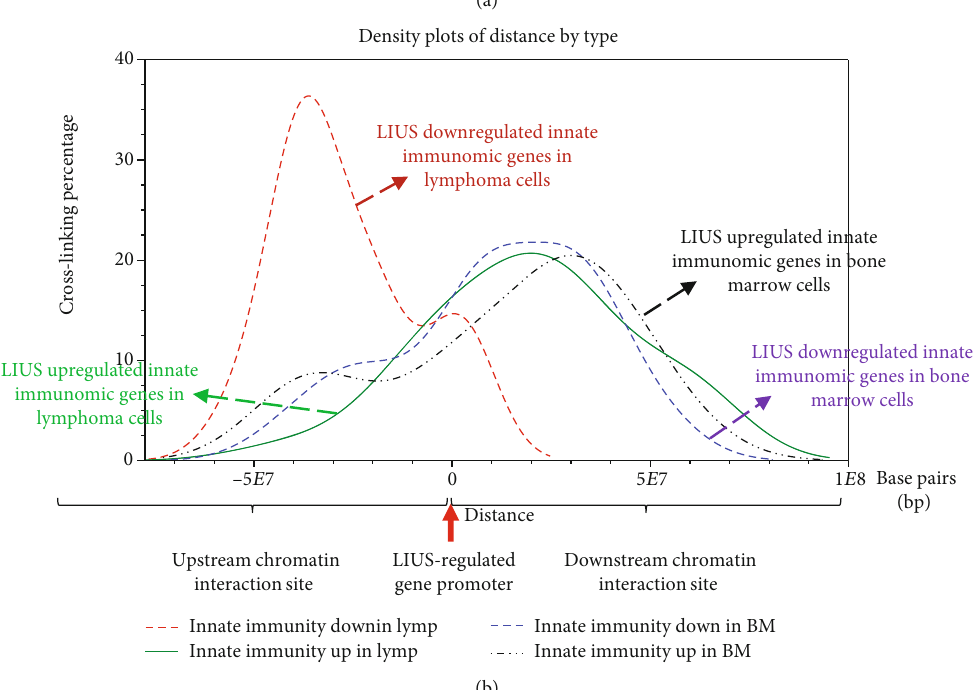
Figure 10: (a) Innate immunome chromatin looping makes long-range interactions that can be regulated by low-intensity ultrasound (LIUS). (a) Chromatin is a whole structure of complex DNA and proteins; it forms the chromosomes of eukaryotic organisms and is packaged inside the nucleus. Nucleosome is a basic unit of chromatin, consisting of a length of DNA coiled around a core of histones. (B) Chromatin